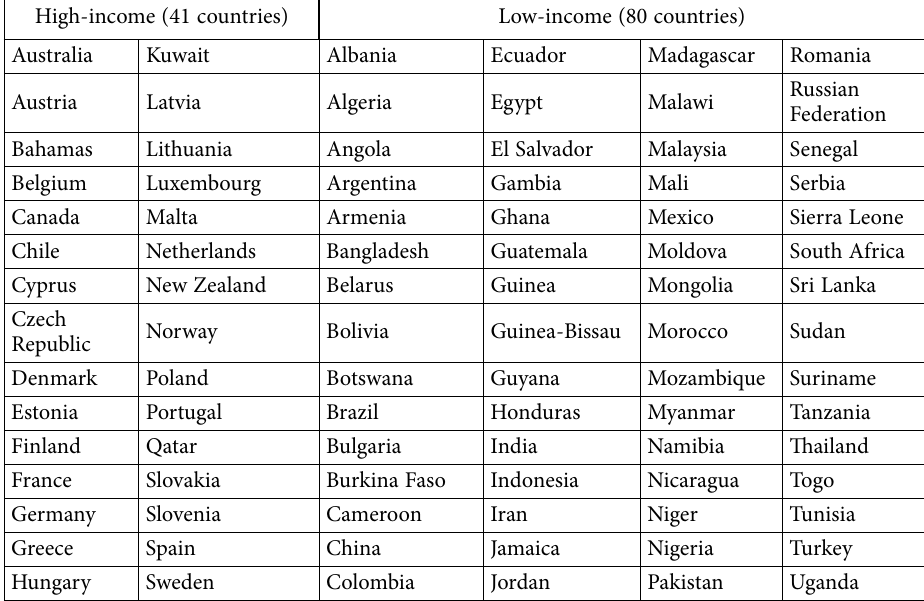
Table A2. List of countries classified by income level High-income (41